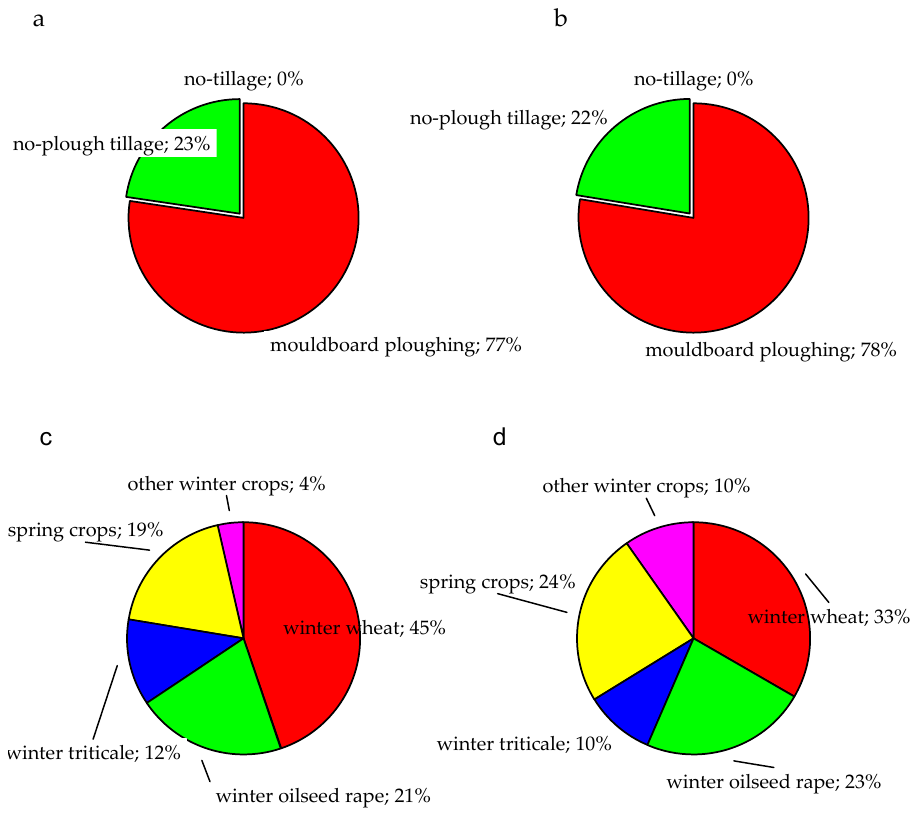
Figure 1. Structure of the tillage systems ( a , b ) and cultivated plants ( c , d ) in crop fields with herbicide-resistant ( a , c ) and susceptible ( b , d ) populations of Centaurea cyanus L. in two or three successive growing seasons.